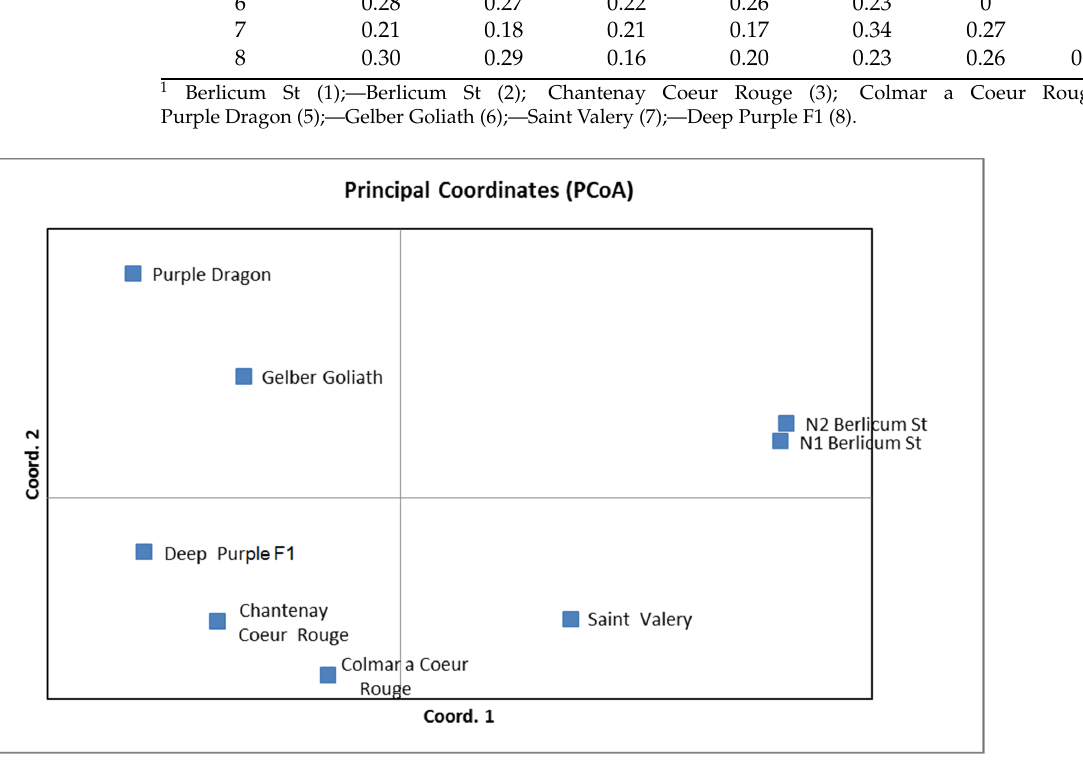
Figure 2. Representation of genetic distance values using principal component analysis (PCA) among eight carrot genotypes.